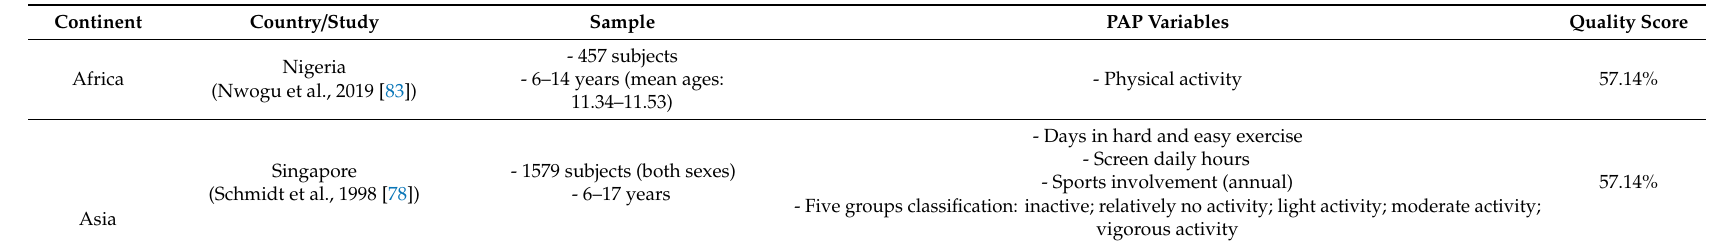
Table 5. Summary of the studies that used questionnaires and observation to assess